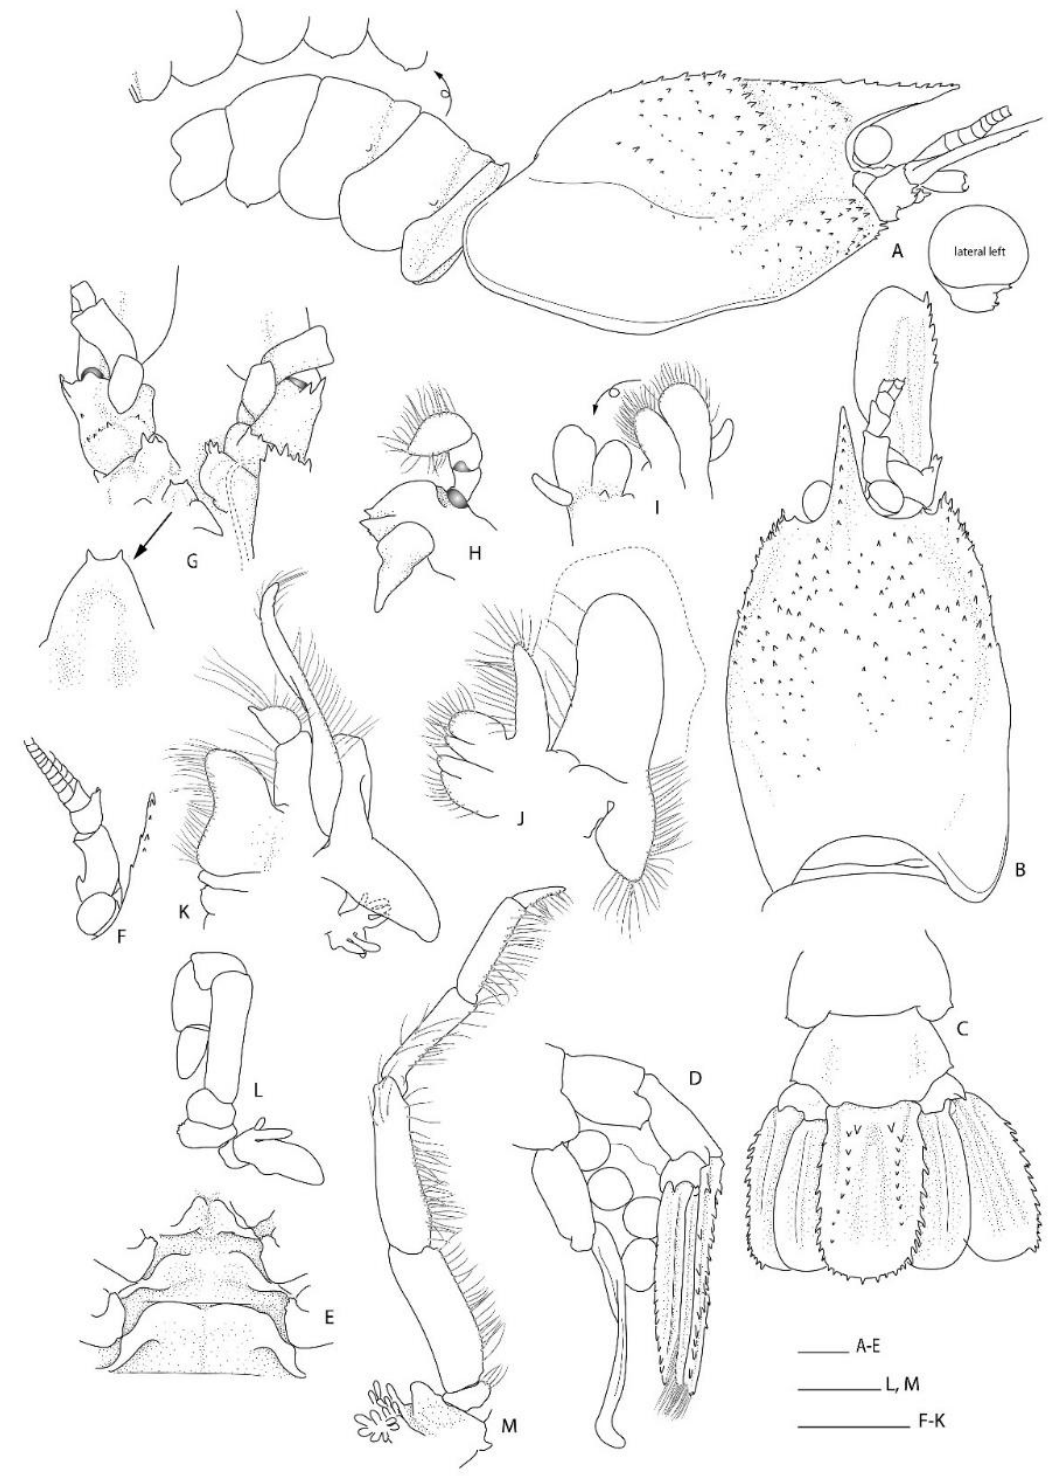
Figure 12. Spongicoloides sonne sp. nov., holotype F ov. (NIWA 127111). ( A ) Carapace and pleon, lateral, with inset of left pleural margins and enlarged lateral left ocular peduncle. ( B ) Carapace and cephalic appendages, dorsal. ( C ) Pleonites 5 and 6, urosome and telson, dorsal.( D ) Pleura 4–6 with pleopod, urosome and telson, lateral. ( E ) Thoracic sternites 6–8 with coxae of pereiopods, ventral. ( F ) Rostrum, left antennule and ocular peduncle, dorsal. ( G ) Left and right antennae, left pterygostomian margin, epistome and labrum, ventral. ( H ) Left mandible with paragnath, inner and outer view. ( I ) Left maxillule, inner and outer view. ( J ) Left maxilla. ( K ) Left Mxp1. ( L ) Left Mxp2. ( M ) Right Mxp3. Scale bars = 2 mm.